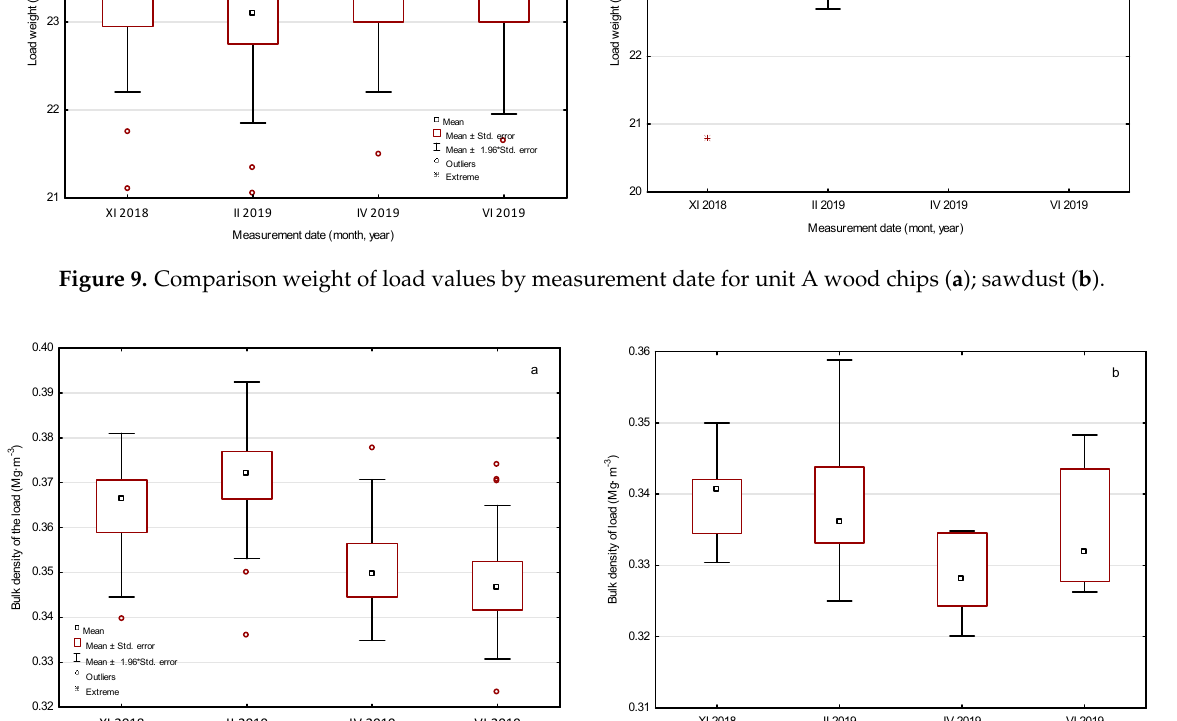
Figure 10. Comparison bulk density (Mg ⋅ m − 3 ) values by measurement date for unit A wood chips ( a ); sawdust ( b ).